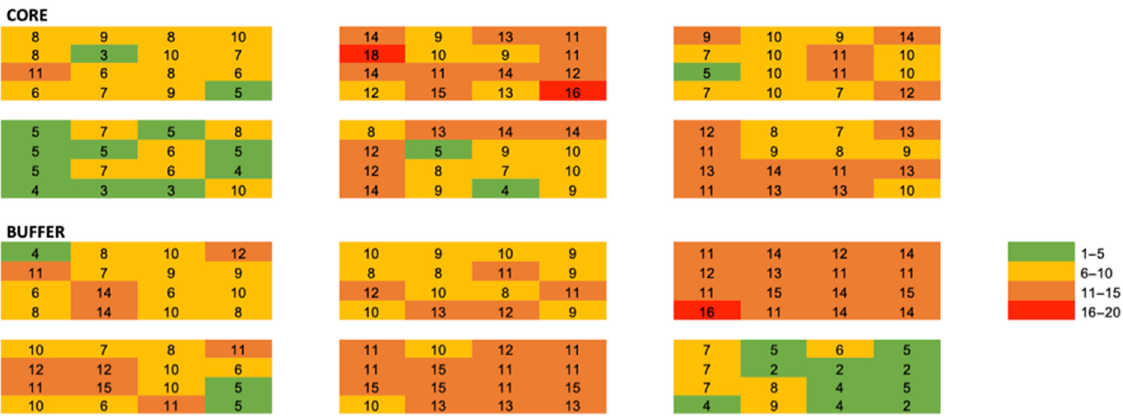
Figure 3. Heat map of total ant abundance among all plots and quadrats.